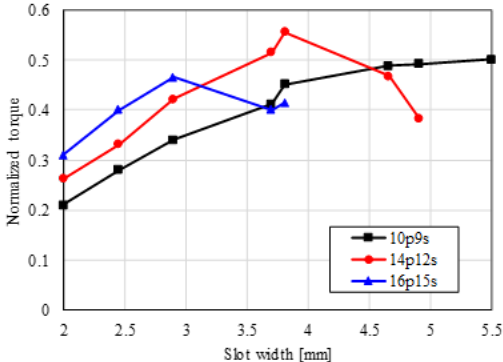
Figure 14. Generated torque with respect to slot width.